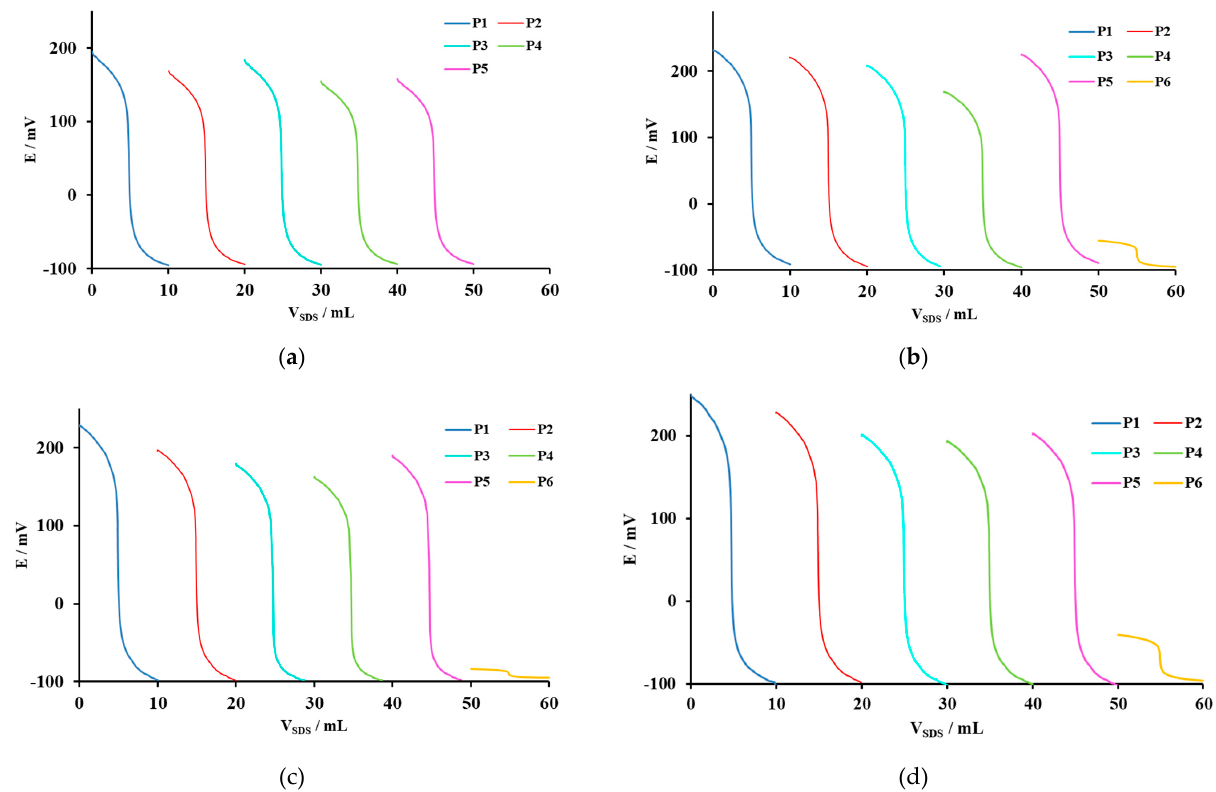
Figure 2. Potentiometric titration curves for ( a ) Hyamine 1622, ( b ) CPC, ( c ) CTAB and ( d ) DMIC, using NaSDS as a titrant ( c = 4mM) and DMI-TPB sensors prepared with 6 different plasticizers: 2-nitrophenyl-octyl-ether (P1), bis(2-ethylhexyl) phthalate (P2), bis (2-ethylhexyl) sebacate (P3), 2-nitrophenyl phenyl ether (P4), dibutyl phthalate (P5) and dibutyl sebacate (P6). Some curves are displaced laterally and/or vertically, for clarity. Table 6. Titration data and statistics for (a) Hyamine 1622, (b) CPC, (c) CTAB and (d) DMIC titration with SDS (c = 4 mM) using DMI-TPB sensors prepared with six different plasticisers (P1-P6). Δ E , mV is the difference between the end and the start potential; d E /d V is the value of first derivative in the end-point. The statistics were based on five independent meas- urements.